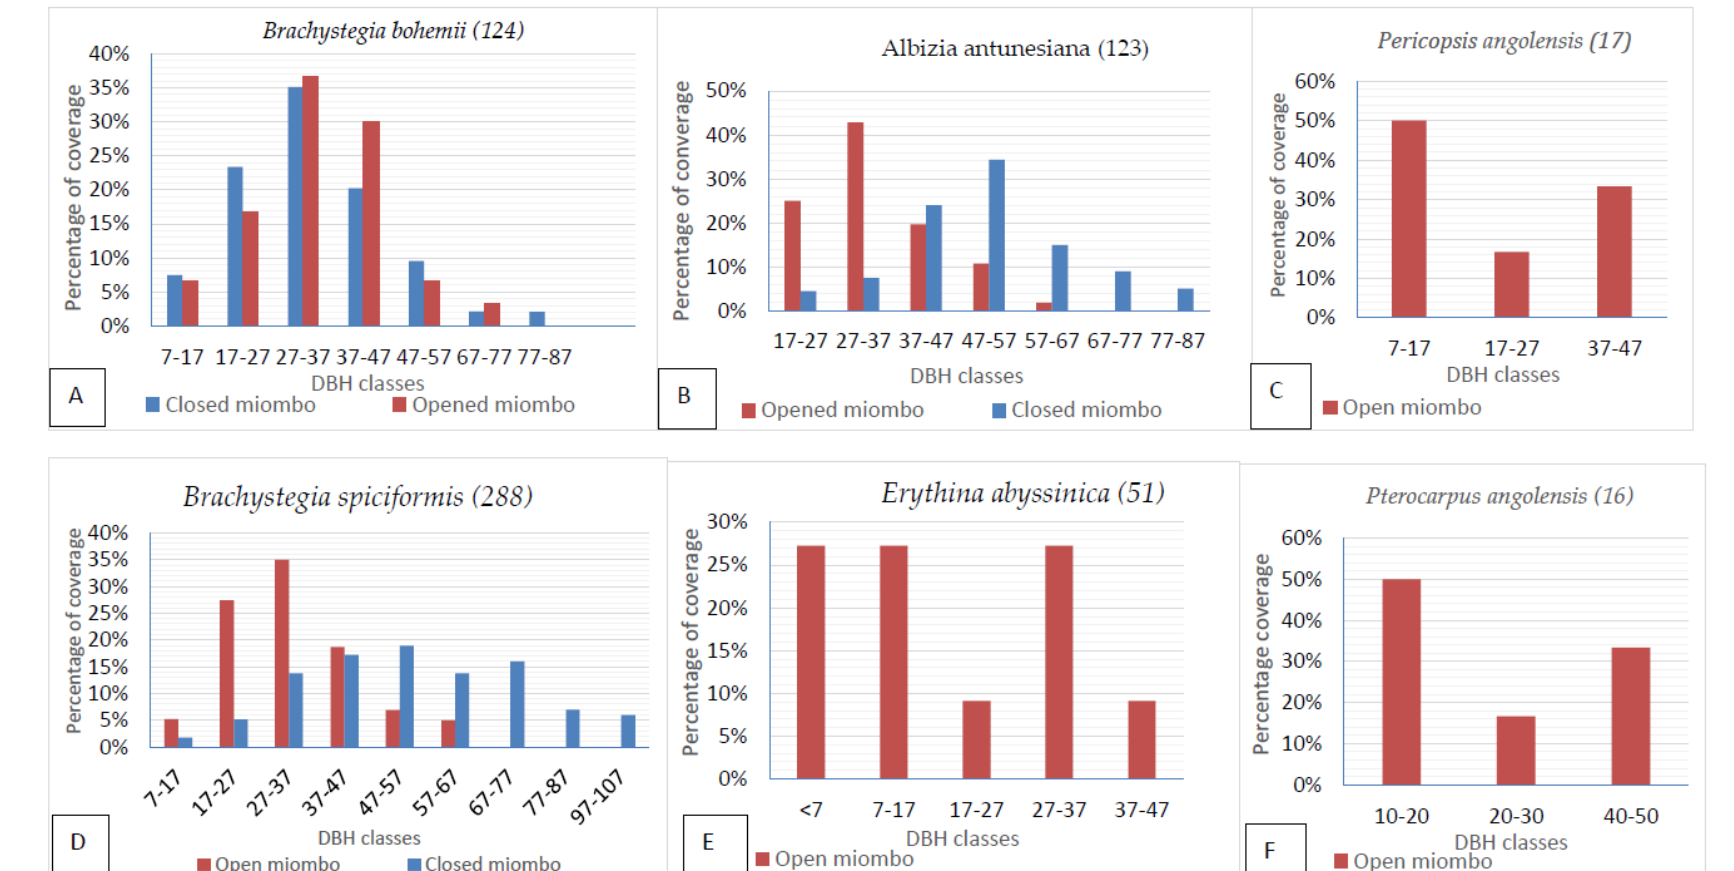
Figure 5. Diameter class distribution of miombo tree species The numbers in the parentheses represent the total count of the species collected. Part ( A ) shows Brachystegia boehmii (94 trees in open miombo and 30 trees in closed miombo), part ( B ): Albizia antuneziana (56 trees in open miombo and 67 in closed miombo), part ( C ): Pericopsis angolensis (17 trees in open miombo), part ( D ): Brachystegia spiciformis (230 trees in open miombo and 58 in closed miombo), part ( E ): Erythina spp. (51 individuals in open miomno) and part ( F ): Pterocarpus angolensis ( 16 trees in open miombo ).